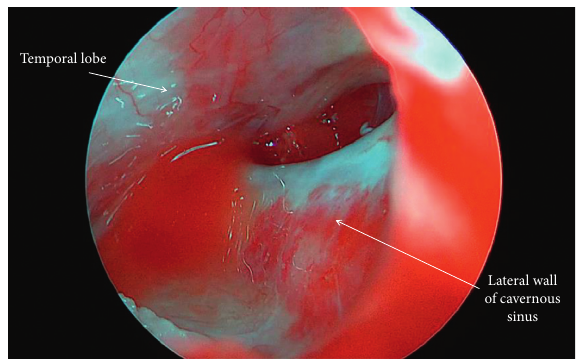
Figure 8: Intraoperative photo of Meckel’s cave following epi- dermoid resection. The endoscope was advanced into the dural opening for visualization of Meckel’s cave. The medial wall of Meckel’s cave is contiguous with the lateral wall of the cavernous sinus. Temporal lobe is noted